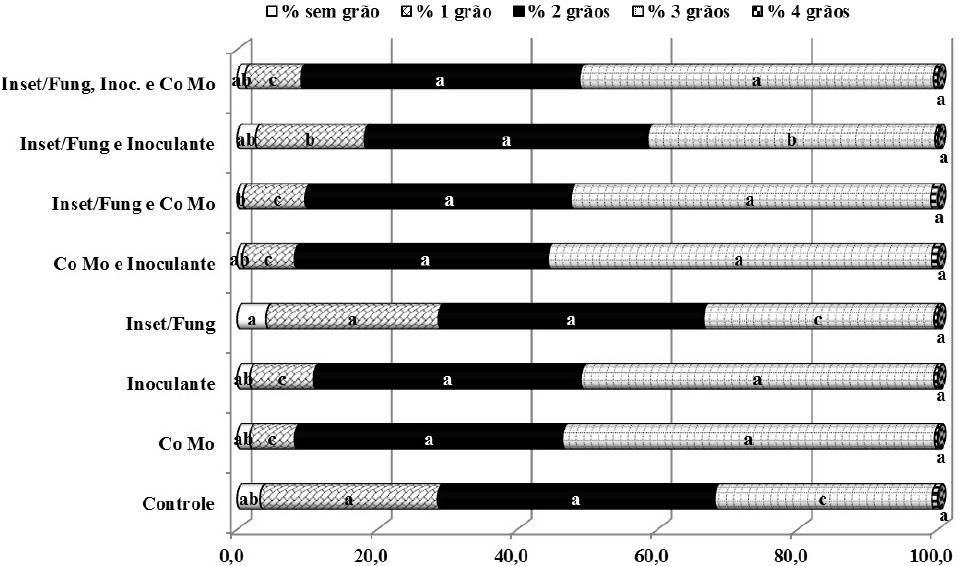
Figura 6. Percentual de vagens de soja com zero, um, dois, três e quatro grãos formados em função de diferente combinação de tratamentos de sementes. Safra 2010/11. Médias seguidas de mesma letra entre barras não diferem pelo teste de Tukey